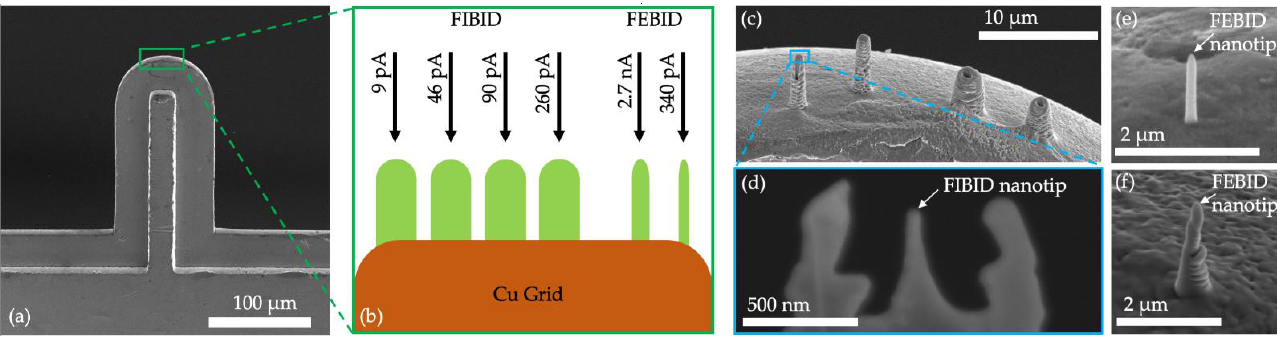
Figure 2. Process of preparing PtC nanotips for EDX analysis with ( a ) a Omniprobe lift-out Cu grid and ( b ) the principle of depositing PtC bumps/tips by FIBID/FEBID, ( c ) the SEM image of the deposited PtC bumps by FIBID, ( d ) the SEM detail image of a final FIBID nanotip, ( e ) the 340 pA and ( f ) the 2.7 nA FEBID nanotip deposited without additional patterning.